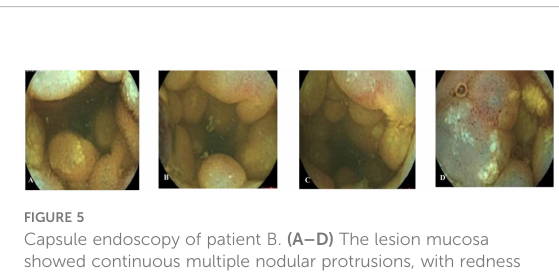
FIGURE 5 Capsule endoscopy of patient B. (A – D) The lesion mucosa showed continuous multiple nodular protrusions, with redness and erosion on the surface.